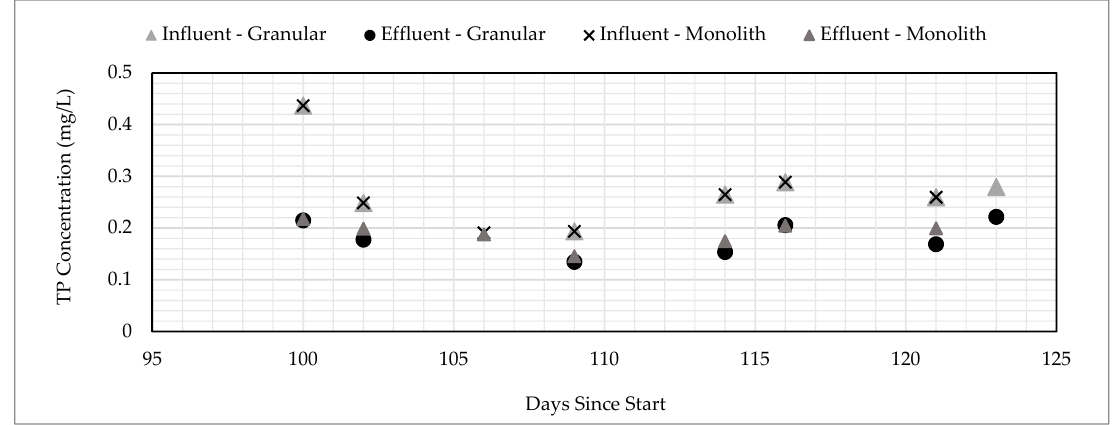
Figure 8. Comparison of phosphorous (P) removal by the monolithic and granular GNEM.